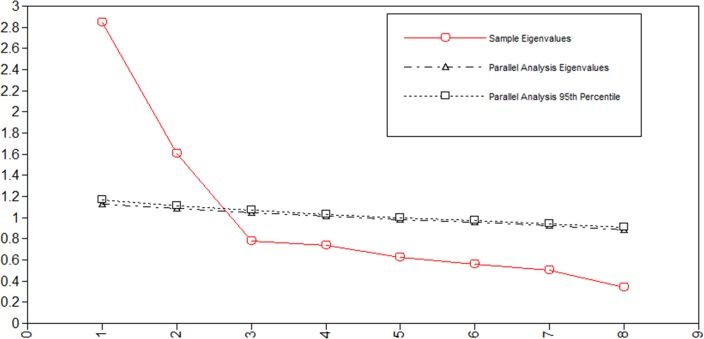
Scree plot for EFA.